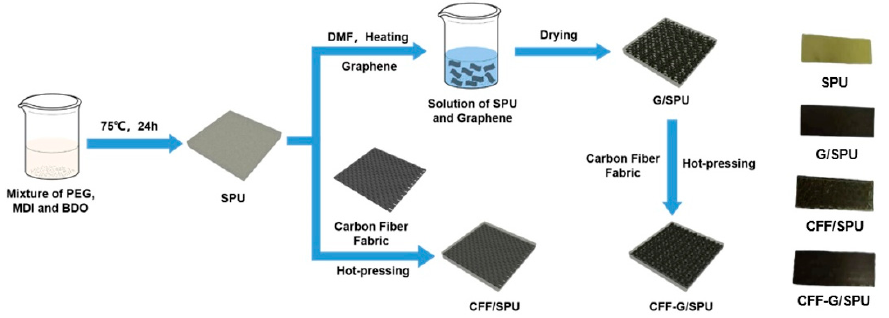
Figure 1. Schematic illustration of preparation method of SPU, G/SPU, CFF/SPU and CFF-G/SPU materials and their photographs. materials and their